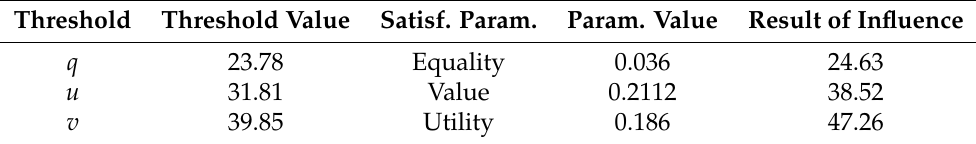
Table 13. Preference thresholds influenced by satisfaction parameters from Table